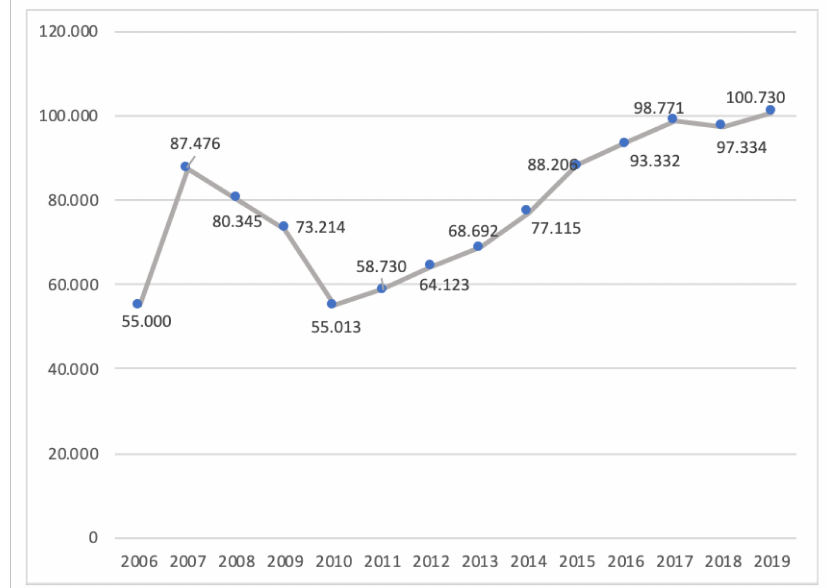
Figure 4. Evolution in the number of visitors to Las M é dulas. Source: Author’s own based on data provided by the Visitor